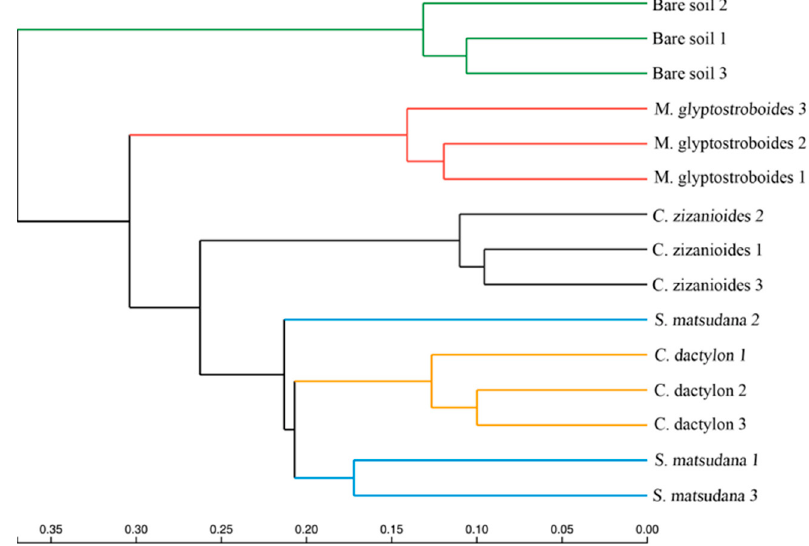
Figure 4. Unweighted pair group method with arithmetic mean (UPGMA) clustering tree based on the Bray–Curtis distance matrix. The digital number represented three biological replicates for each sample.